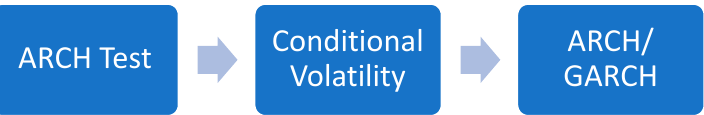
Figure 1. Methodology to test the ARCH effect.